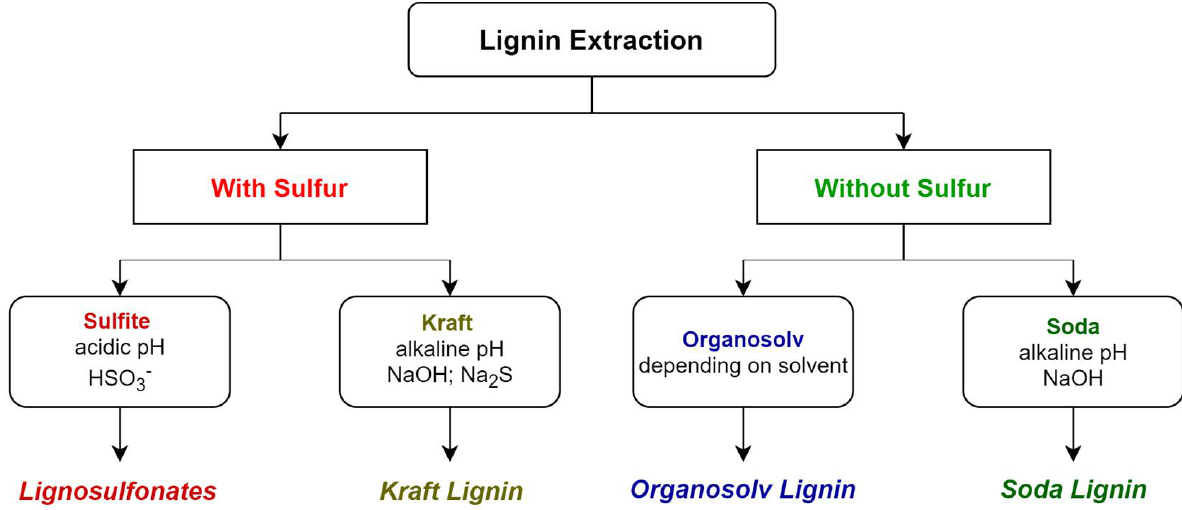
Figure 3. Summarisation of industrial lignin isolation processes and their respective products.